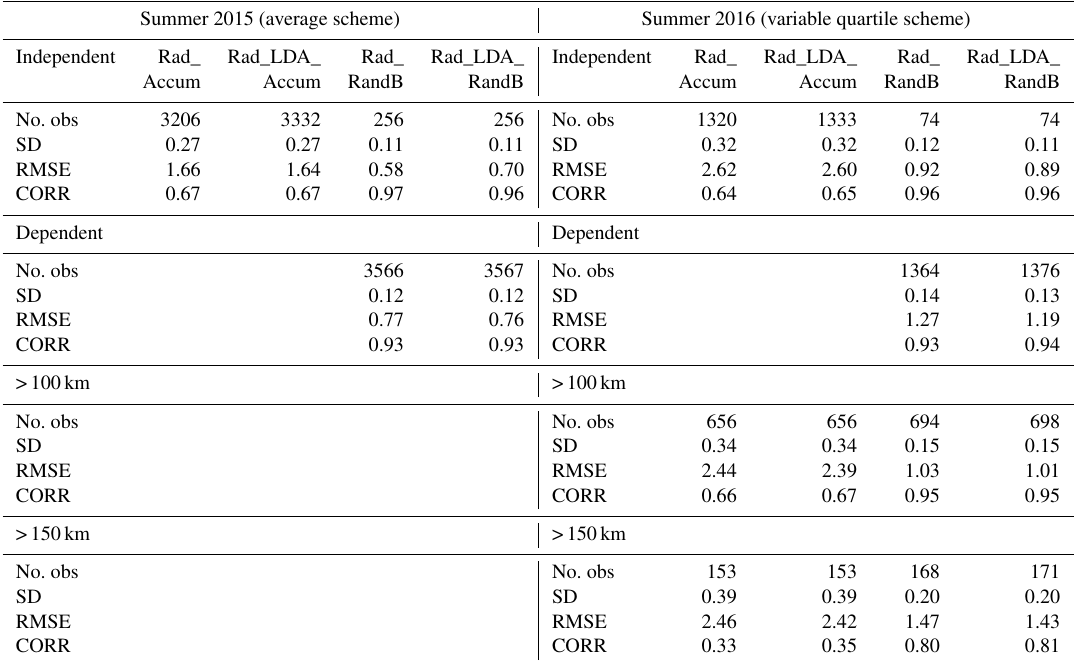
Table 1. Precipitation accumulation results from summer of 2015 (i.e., dataset c, left column) and 2016 (i.e., dataset d, right column), for periods of the 25 intensive lightning days (e.g., >100 CG strokes per day) during both years. Precipitation results are shown for radar (Rad_Accum) and radar merged with lightning data (Rad_LDA_Accum), together with and without gauge measurements included with the RandB method (Rad_RandB and Rad_LDA_RandB, respectively). In the lowest panels, only data from more than 100 or 150km from the nearest radar are used. Verification is performed against both independent and dependent stations, i.e., those used or left out from the gauge